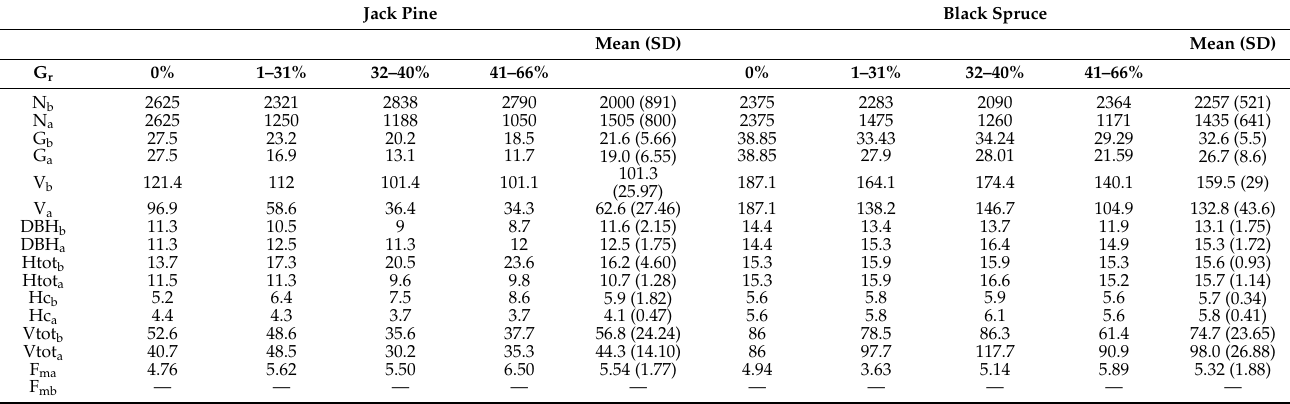
Table 1. Jack pine and black spruce tree and stand characteristics in Canadian boreal forest of Northwestern Quebec, with ages ranging between 48 and 82 years for jack pine, and between 93 and 95 years for black spruce.